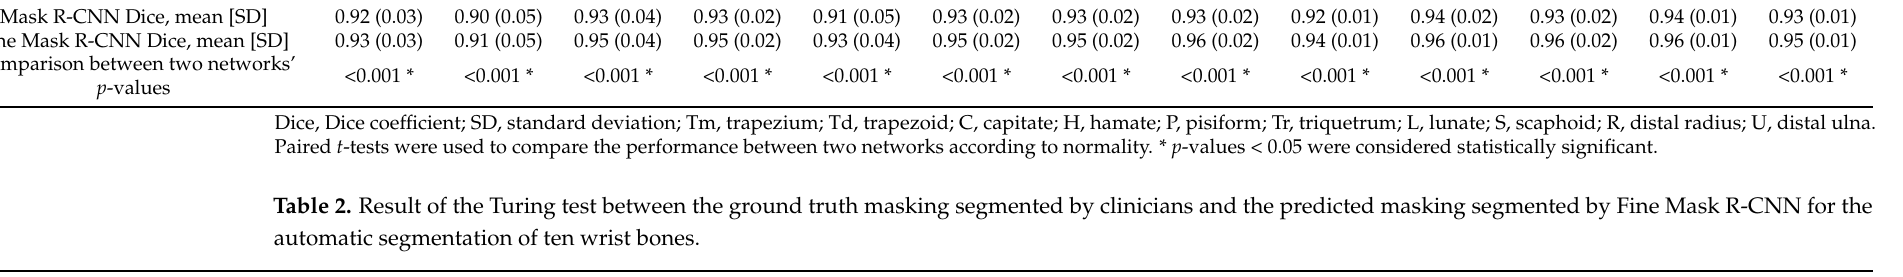
Table 2. Result of the Turing test between the ground truth masking segmented by clinicians and the predicted masking segmented by Fine Mask R-CNN for the automatic segmentation of ten wrist bones.